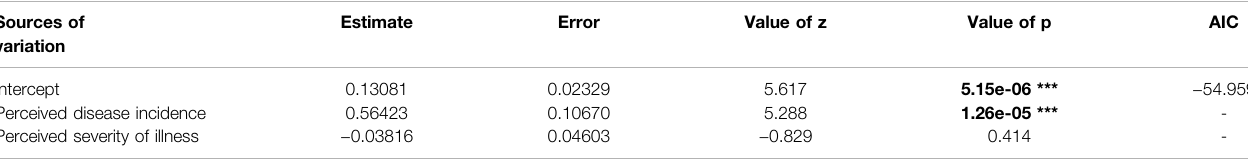
TABLE 7 | Generalized Linear Model used to test the effect of disease incidence and severity perceived by Carão farmers on the frequency of used adaptive strategies. The p -values for signi fi cant predictors are highlighted in bold. Signi fi cance code p -value: *** [0, 0.001]; ** (0.001, 0.01]; * (0.01, 0.05]; (0.05, 0.1]; (0.1, 1]. Sources of